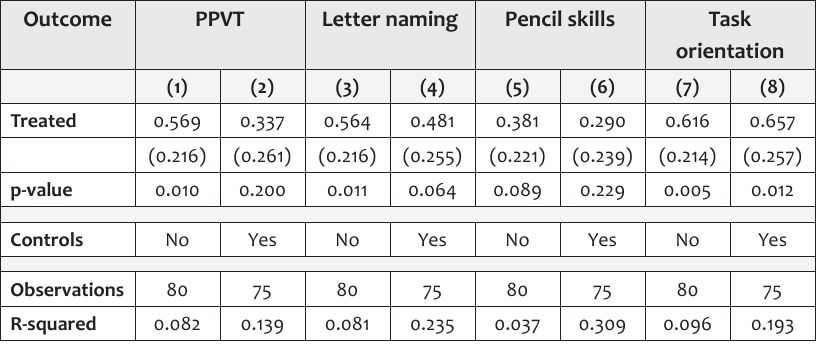
Table 4: Center attendance and pre-school development